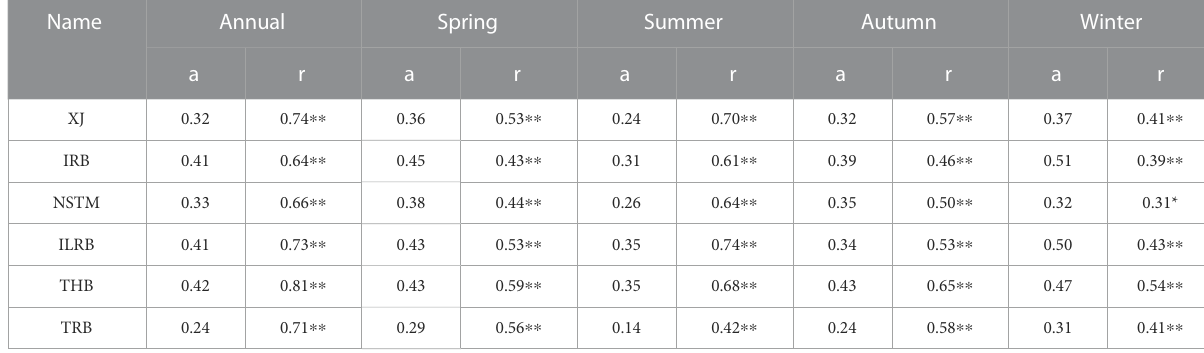
TABLE 1 Variation trends of annual and seasonal temperature in XJ and its sub-regions ( ° C/10 a), and the results of signi fi cance tests.